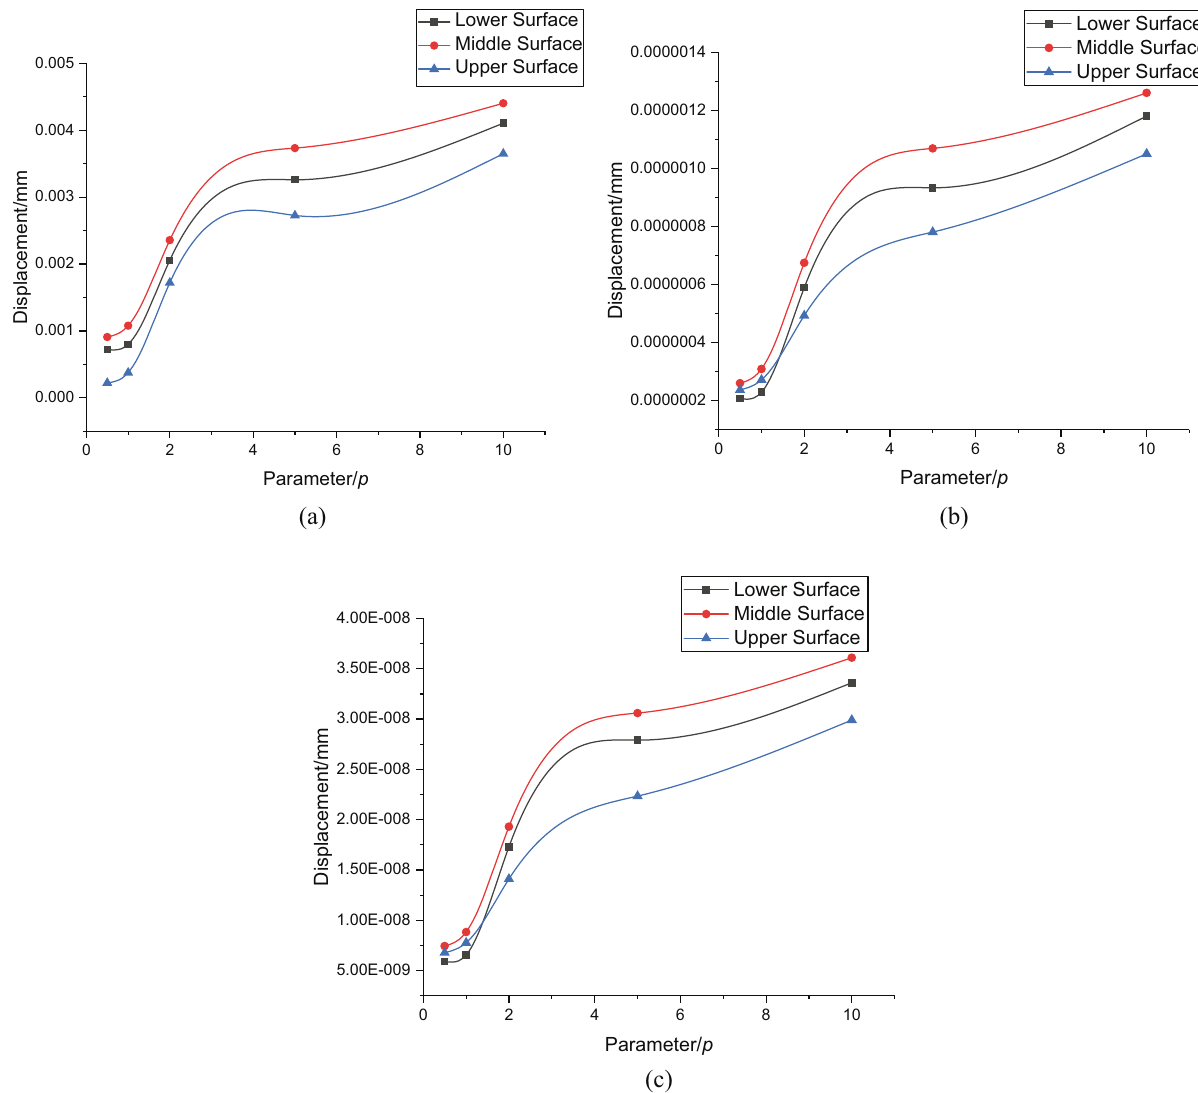
Figure 9: The upper, middle, and lower surface displacement changes with gradient parameters with di ff erent x positions. ( a ) x = 0, ( b ) x = 45, and ( c ) x =